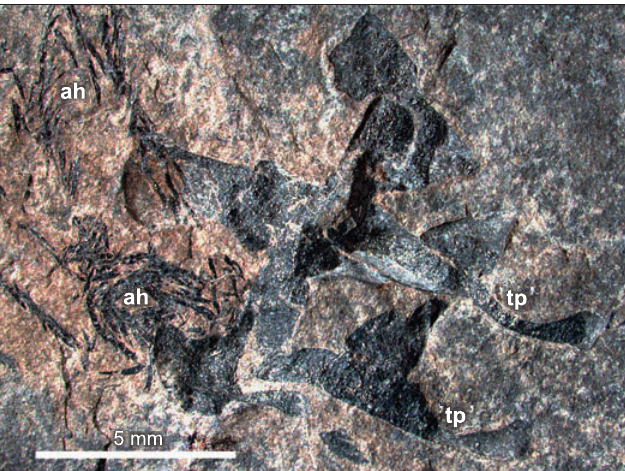
Fig. 4. Coleoid cephalopod Phragmoteuthis bisinuata (Bronn, 1859); lower Carnian, Upper Triassic, Cave del Predil, NE Italy; GBW 2006/011/0001; overview of the “beaks” and arm hooks (enlargement of Fig. 2C 2